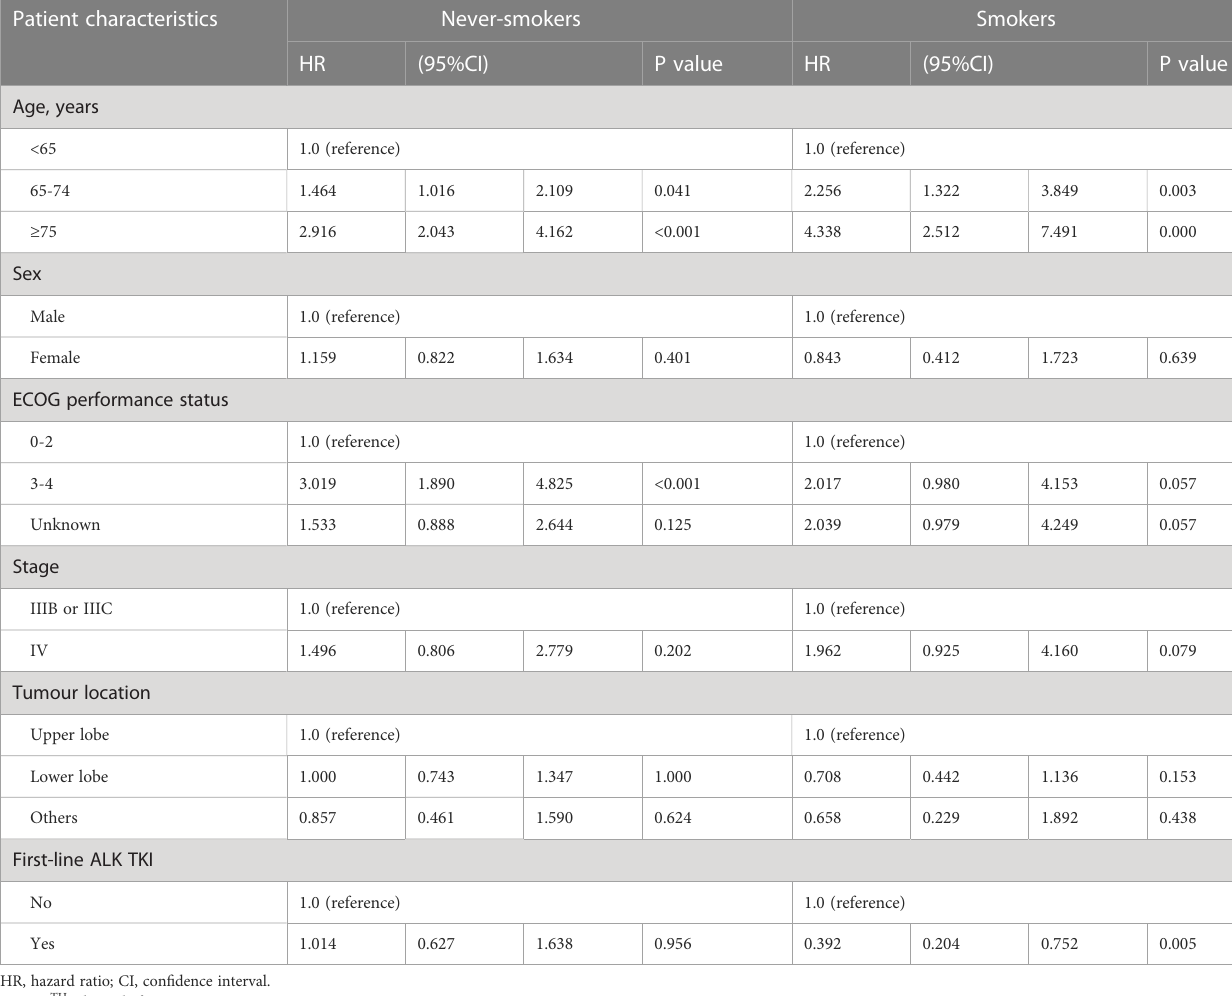
TABLE 3B Multivariable analysis of in fl uencing factors of overall survival in smokers and never-smokers. Patient